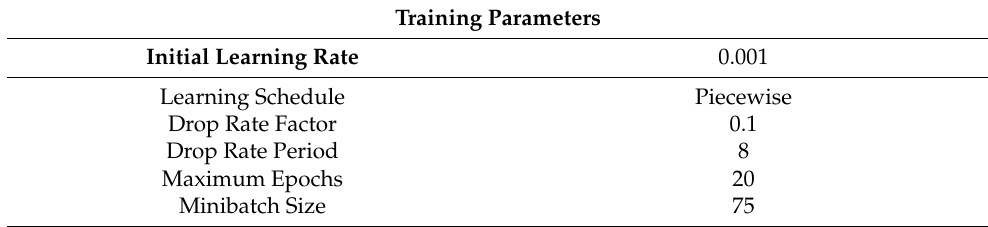
Table 2. Parameters for training the SqueezeNet-based CNN.